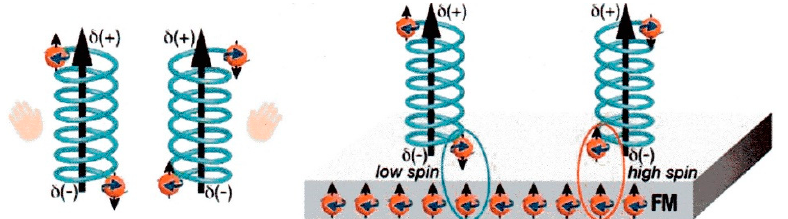
Figure 4. Left : Illustration of the chirality-induced spin selectivity (CISS) effect where the electrical polarization of a chiral molecule is accompanied by an electron spin polarization, with the spin alignment at each pole depending on the specific enantiomer. Right : The interaction between the ferromagnetic surface and the molecule is either low spin or high spin, depending on the specific enantiomer, which depends in turn on the whether the falsely chiral arrangement of molecular alignment vectors (large arrows) are parallel or antiparallel to the ferromagnetic spin vectors (small arrows within the FM surface). Adapted from [57] with permission from the publisher.